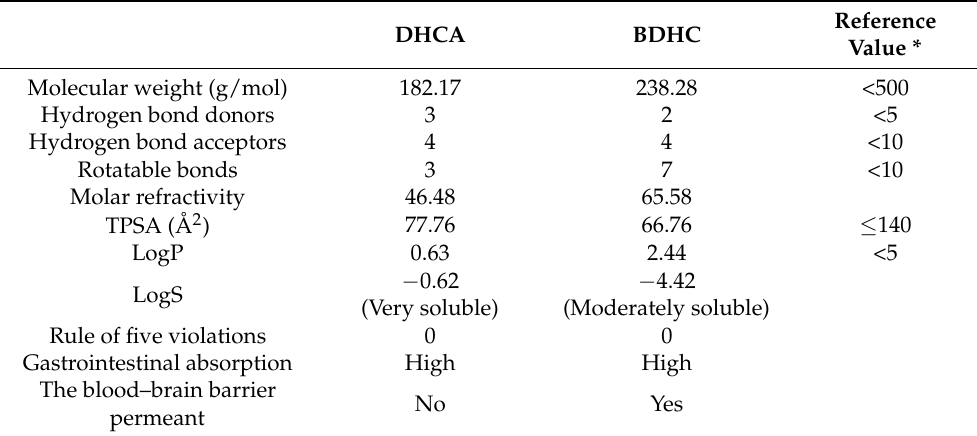
Table 3. Comparison of selected physicochemical descriptors, pharmacokinetic properties, drug- likeness, and ADME (absorption, distribution, metabolism, and excretion) parameters of dihydrocaf- feic acid butyl ester and its precursor.